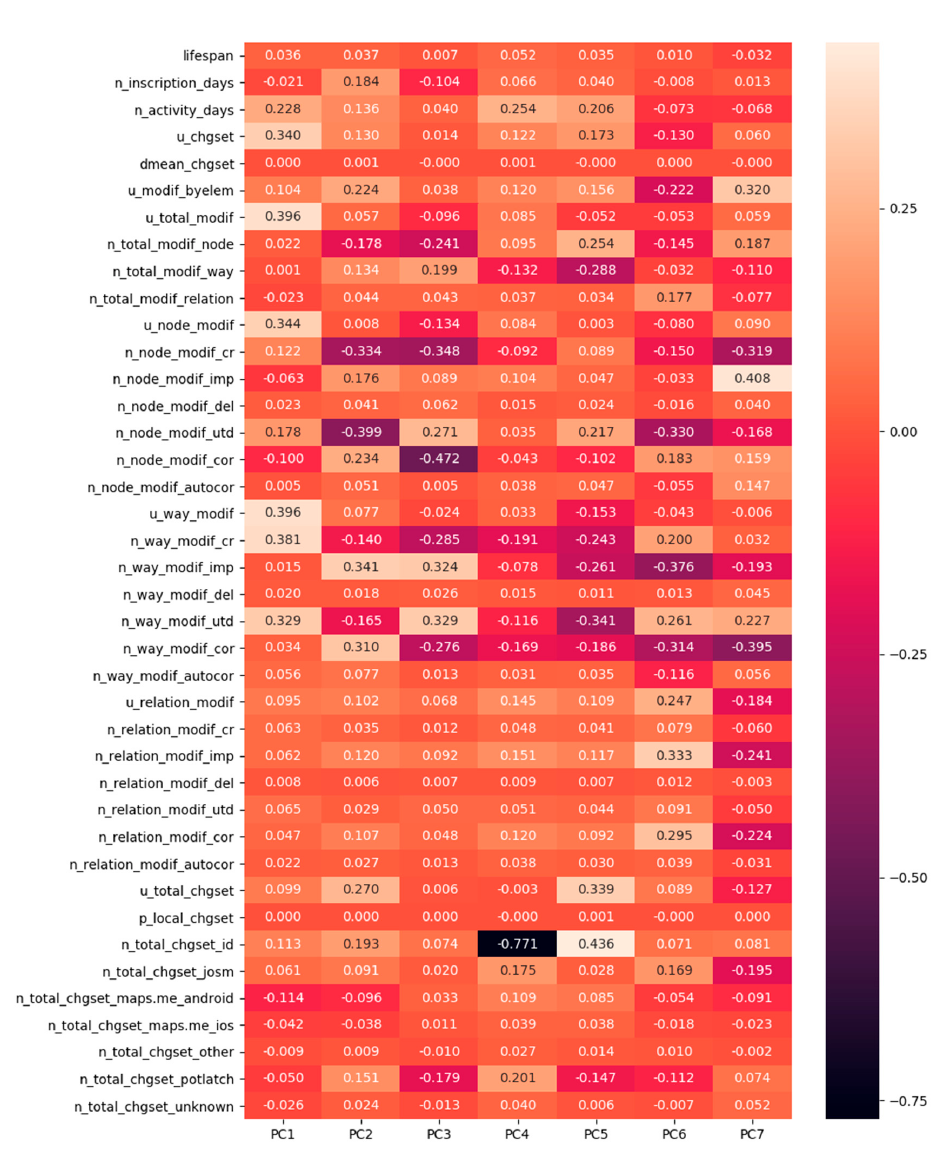
Figure 4. Principal component analysis (PCA) correlation circle.